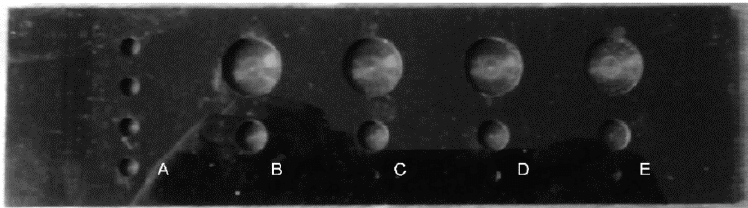
Figure 1. Photograph of acrylic glass test sample side on which defects were simulated marked as A, B, C, D and E series.